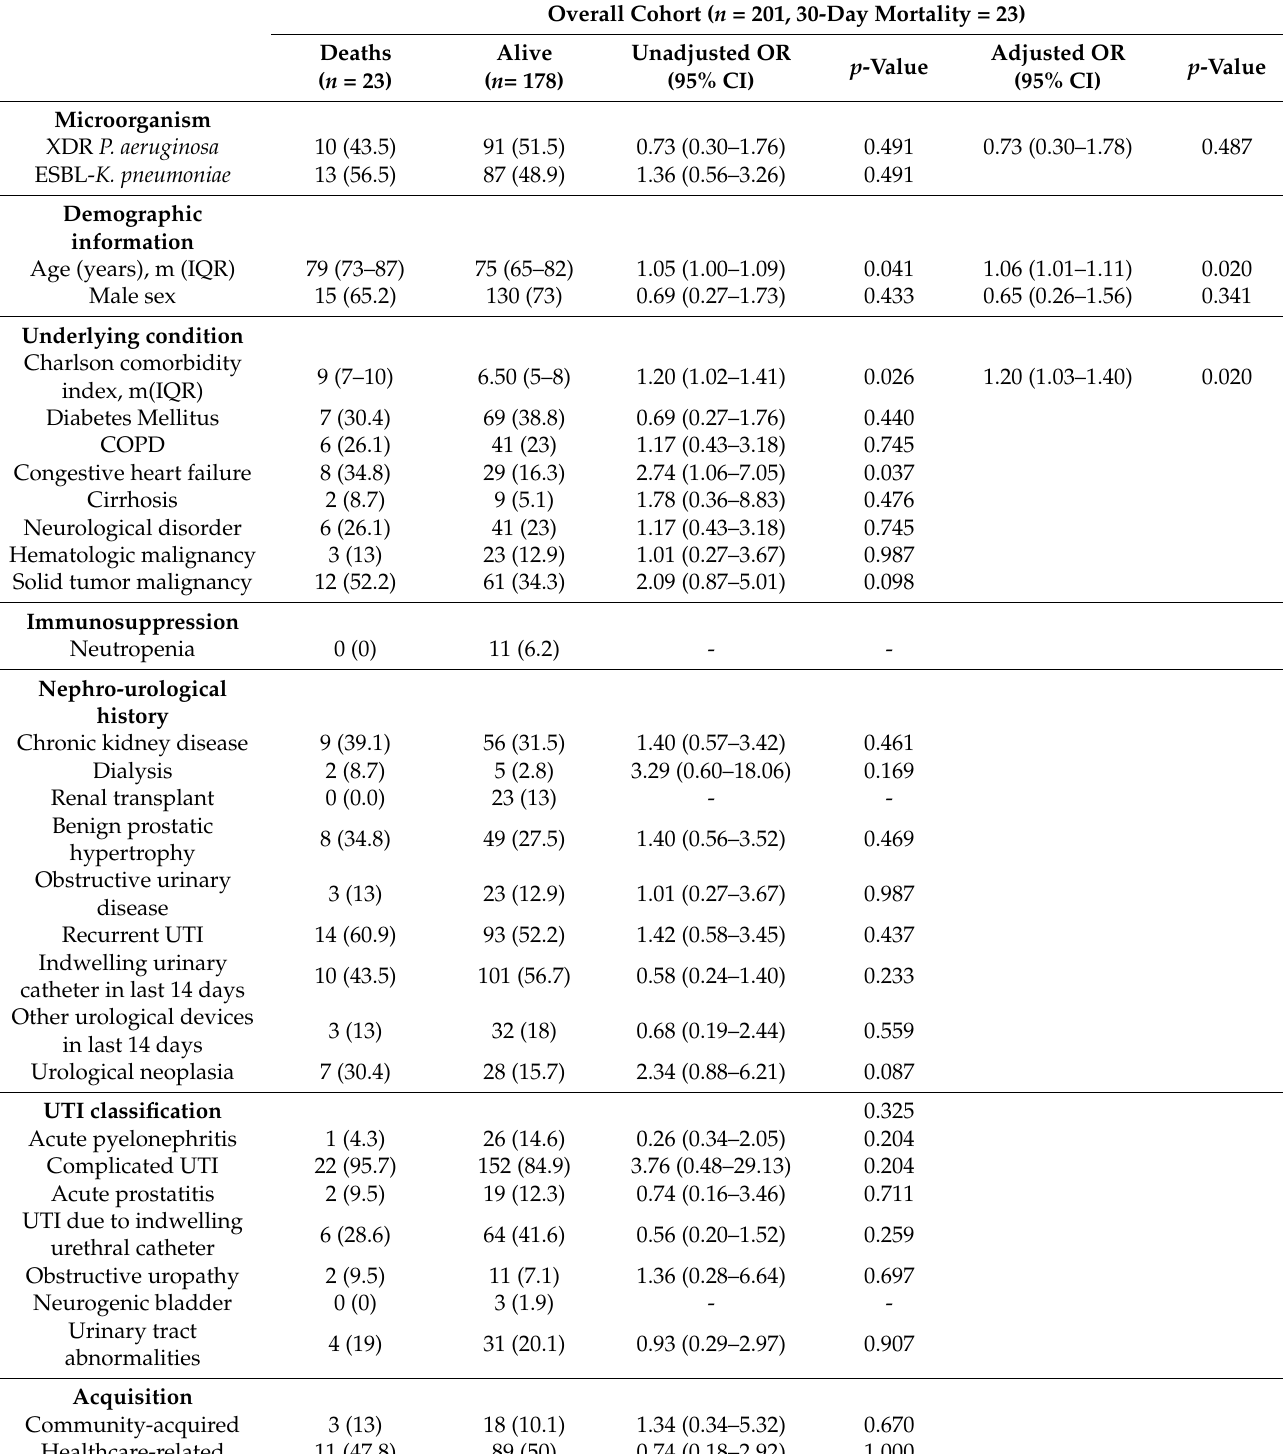
Table 4. Univariate and multivariate analysis of parameters predicting 30-day